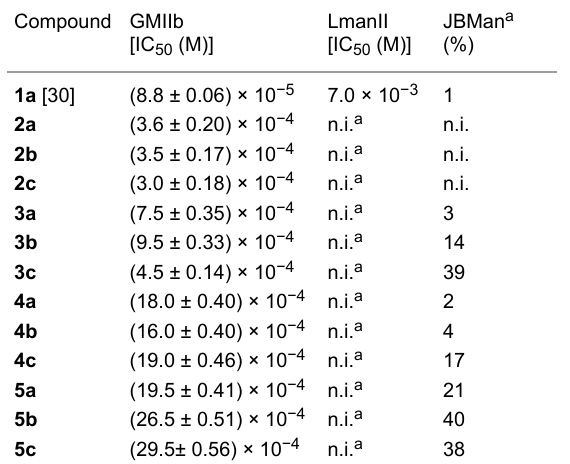
Table 1: Inhibitory activity of pyrrolidines 2–5 against the class II α -mannosidases GMIIb, LManII and JBMan from GH38 family en-